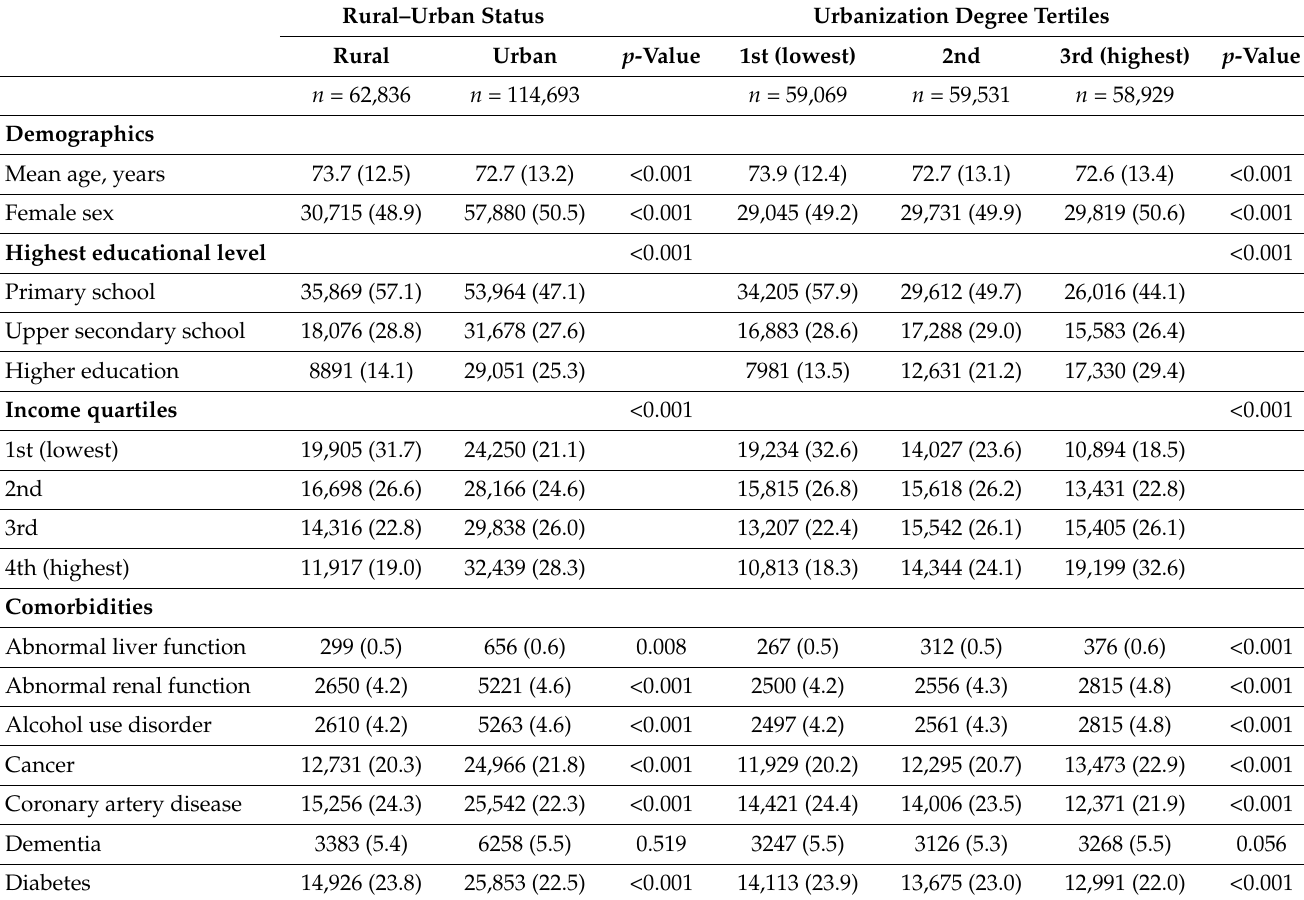
Table 1. Descriptive characteristics of the